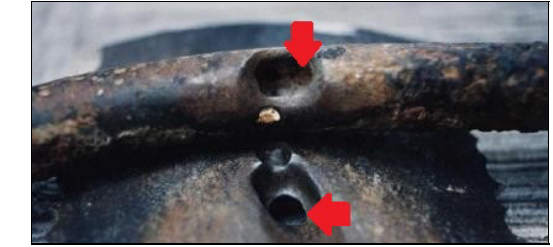
Figure 12 – Corrosion pits in the water pipelines Рис . 12 – Коррозийные питтинги на трубе водопровода Slika 12 – Korozivni pitovi u vodovodnim